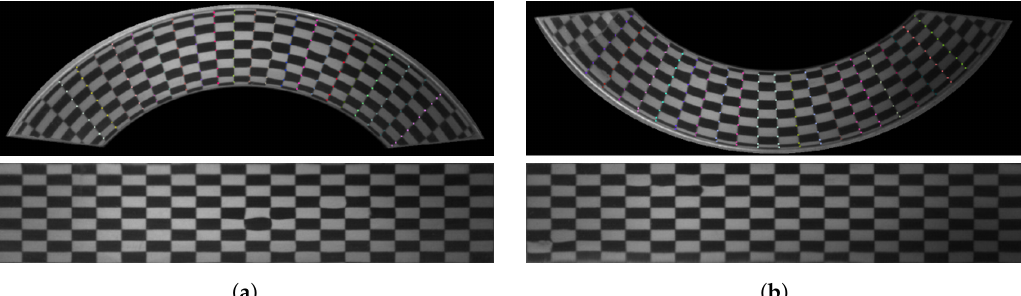
Figure 5. ( a ) The upper mirror with the applied mask and corresponding image of the upper mirror after transforming to a rectangular grid; and ( b ) the lower mirror with the applied mask and corresponding image of the lower mirror after transforming to a rectangular